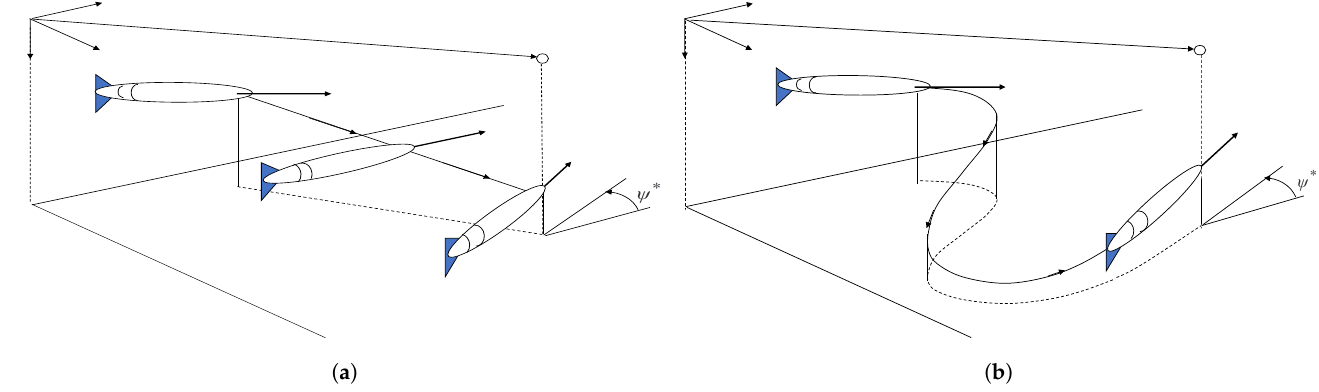
Figure 3. Parking maneuvers from ( a ) short-range and ( b ) long-range